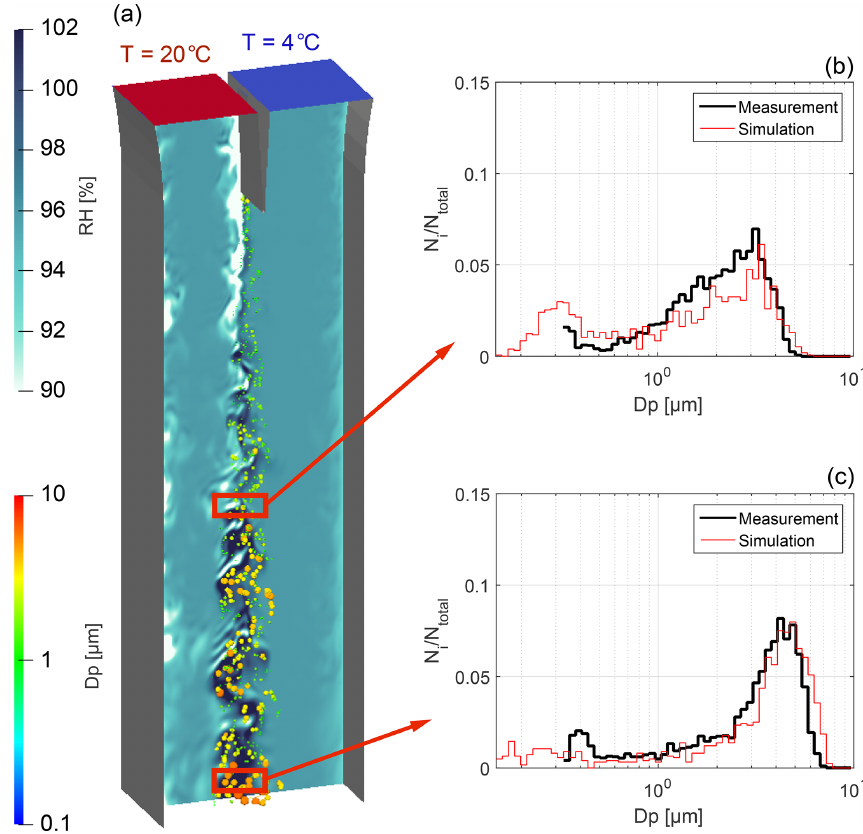
Figure 12. Snapshot of particle simulation with fluctuating relative humidity field in the background and particles colored and sized (not to scale) according to their diameter. (b, c) Droplet formation and growth of monodisperse NaCl particles ( D p , dry = 100nm) for (cid:49)T = 16K measured at two different positions below the aerosol inlet ( b : z 4 , c : z 8 ) for measurements (black line) and simulations (red line).